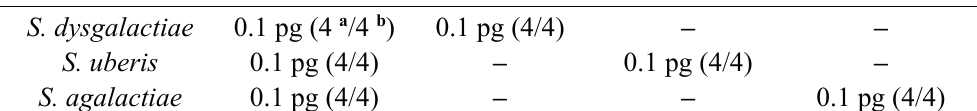
Table 3. Detection limits of four LAMP primer sets for identification and differentiation of Streptococcus dysgalactiae , Streptococcus uberis and Streptococcus agalactiae